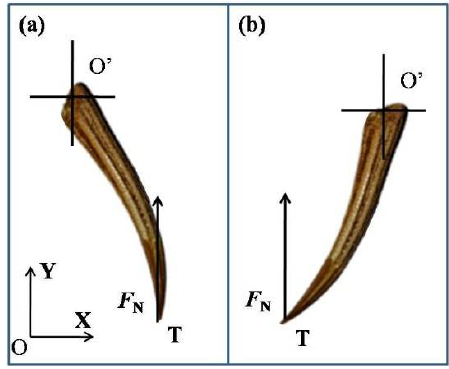
Figure 12. Forces on a dactylopodite during locomotion. ( a ) hitting the ground; ( b ) the supporting state.